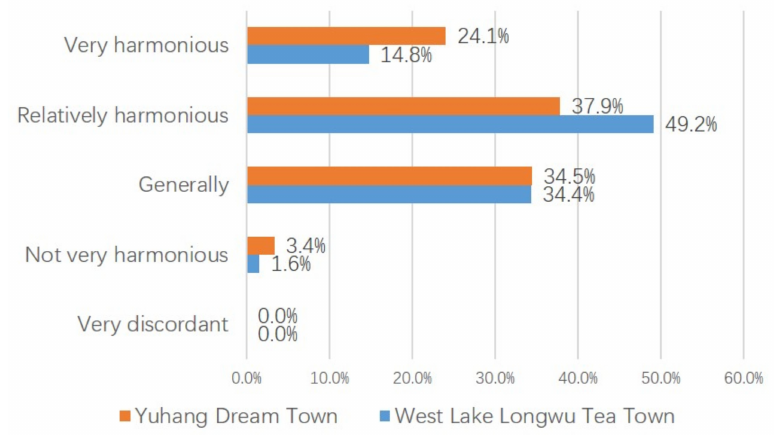
Figure 32. Respondents’ views on the relationship between local residents and migrant workers (source: